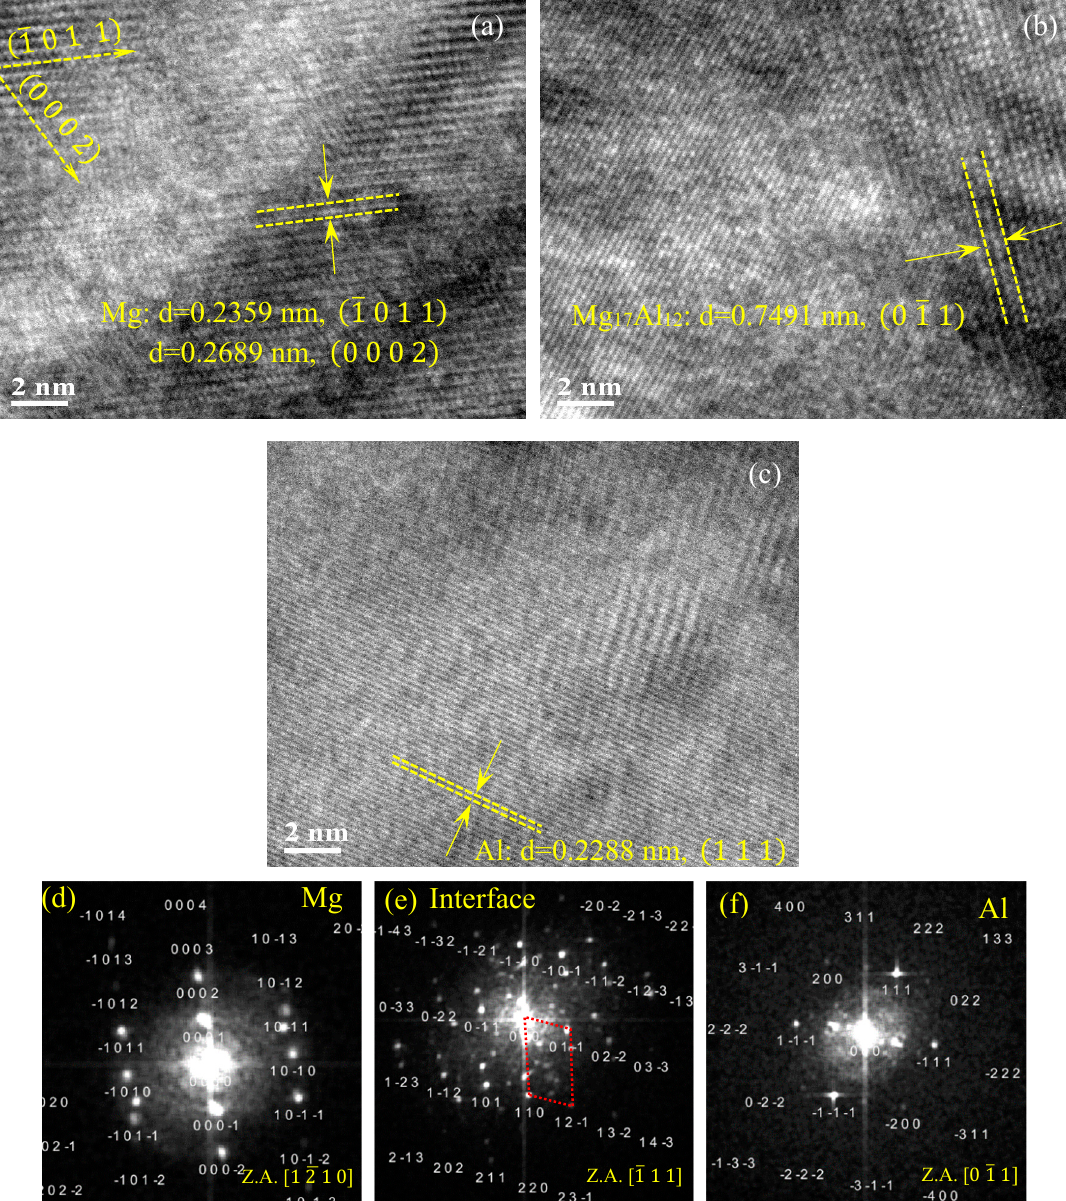
Figure 3. Typical HRTEM images of different zones and the fast Fourier transform (FFT) diffraction patterns of cold sprayed AA7075 on the AZ31B substrate: Mg substrate ( a , d ), interface ( b , e ), and AA7075 coating ( c , f ), separated by the red dashed line in Figure 2.